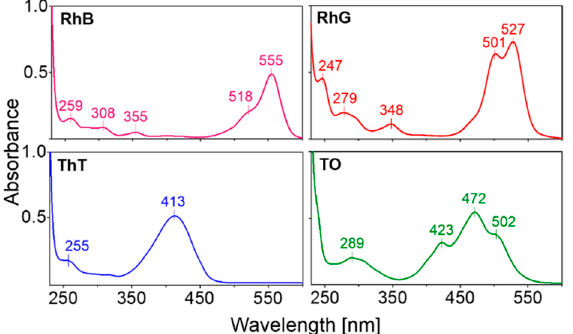
Figure 2. Absorption spectra of 130 µ M ligands used in this study in a 25 mM mRB buffer, pH 7.0.